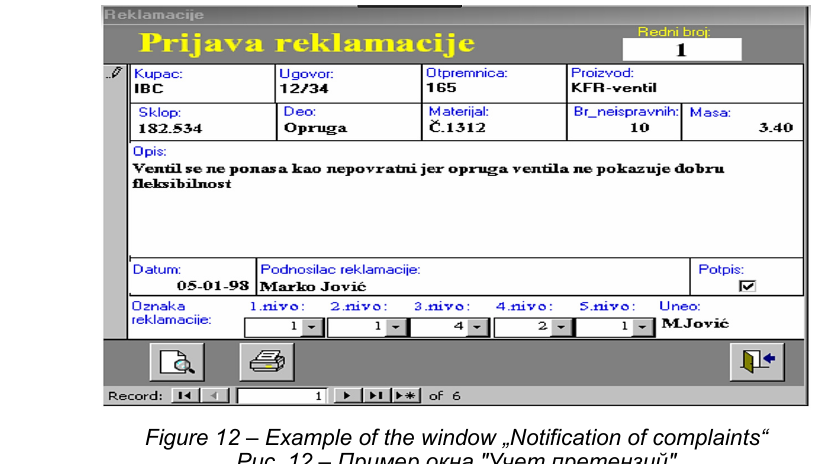
Figure 12 – Example of the window „Notification of complaints“ Рис . 12 – Пример окна " Учет претензий " Слика 12 – Пример прозора „ Пријава рекламације